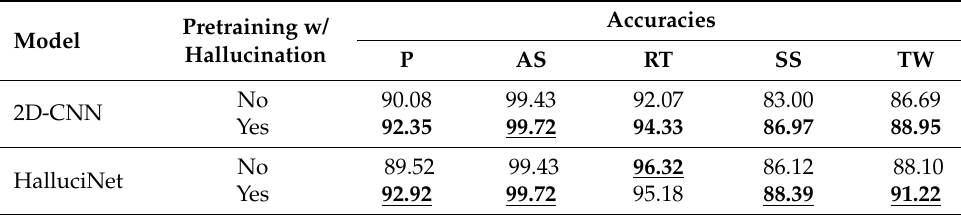
Table 6. Utility of hallucination task in pretraining. Best performances are